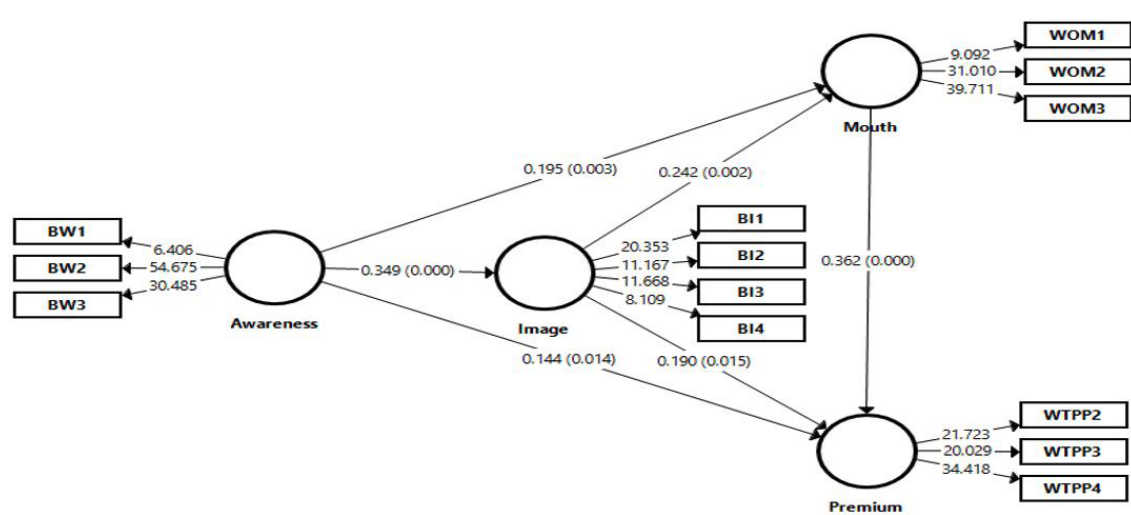
Figure 2: Results of Final Model